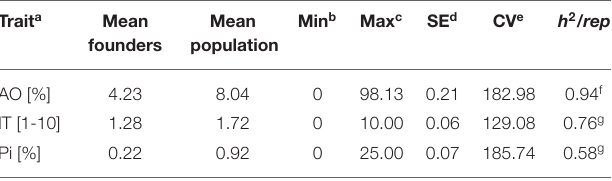
TABLE 1 | Descriptive statistics of raw data and heritability/repeatability for field trials (AO) and seedling test (IT and Pi). Trait